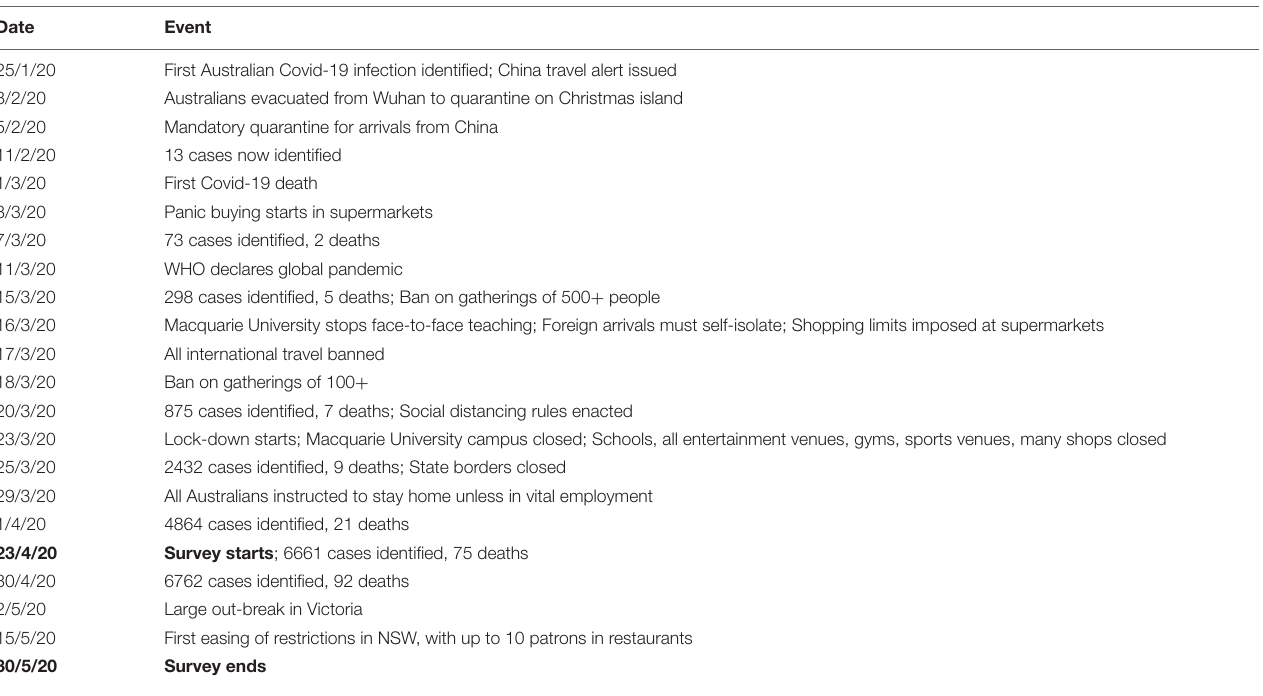
TABLE 1 | Covid-19 timeline in Australia, prior to and during the survey